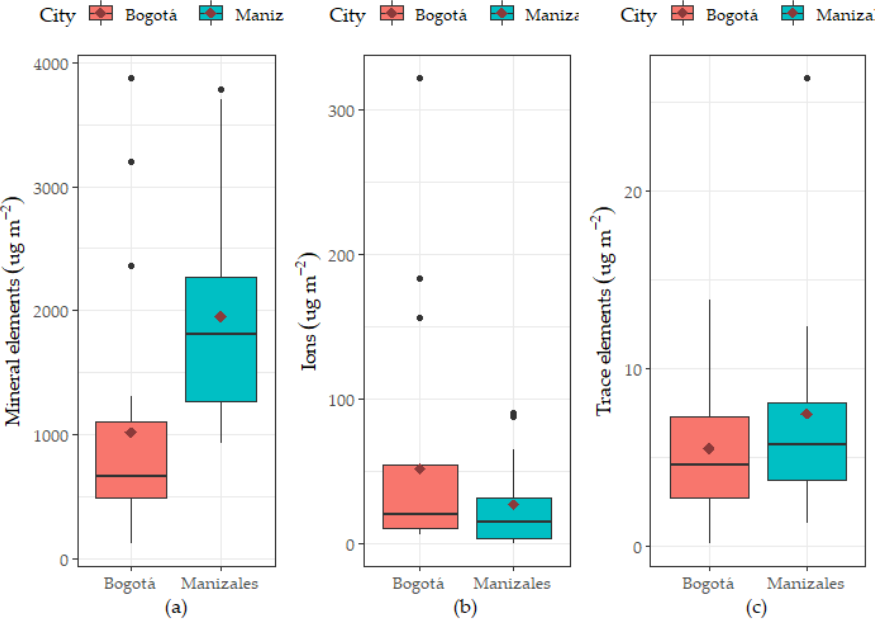
Figure 5. Total load of ( a ) mineral elements, ( b ) ions, and ( c ) trace elements determined for Bogotá and Manizales.